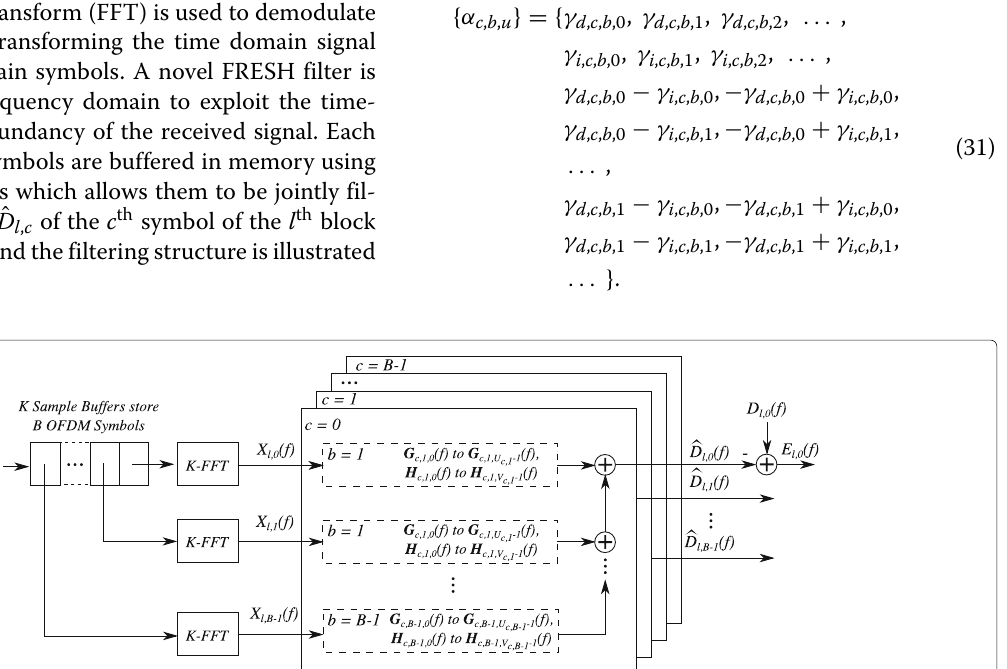
Fig. 4 The PFD structure that exploits spectral redundancy across time and frequency by demodulating and applying a novel FRESH filter. The depth in the image indicates a similar filtering structure with different filter weights for each of the sets of OFDM